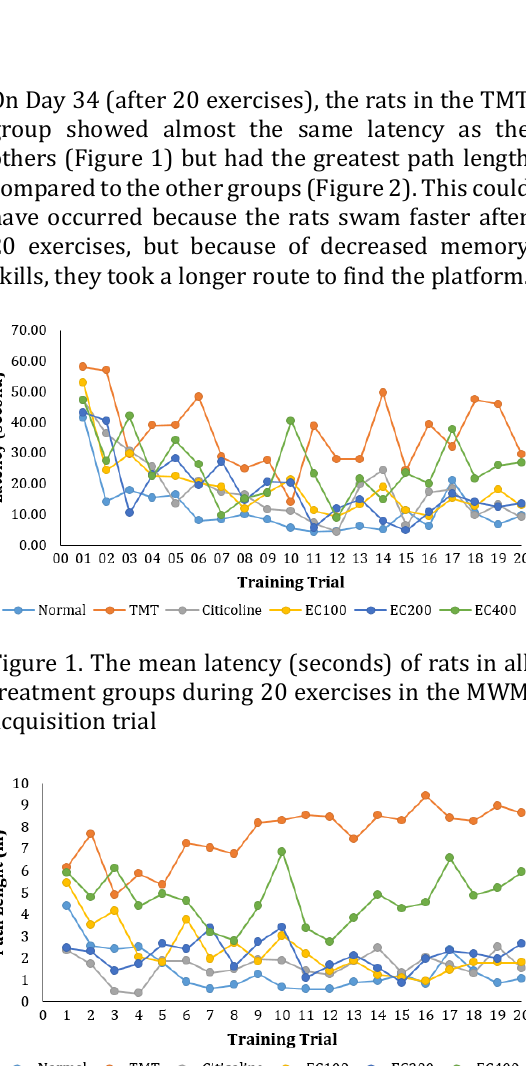
Figure 2. The mean trajectory length (m) of rats in all treatment groups during 20 exercises in the MWM acquisition